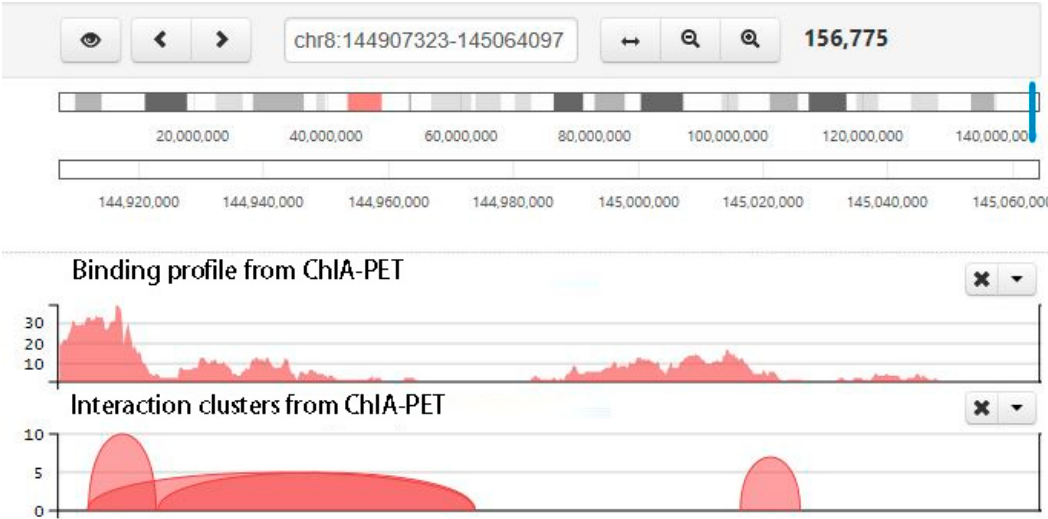
Figure 9. Screenshot of chromatin clusters and protein-binding peaks from ChIA-PET. There are multiple tracks, including interaction clusters and binding profile from ChIA-PET. In the interaction cluster track, two ends of each curve are the interaction anchors, and the height of the curve is the pet count between the interaction anchors. The higher the curve, the stronger the interaction.